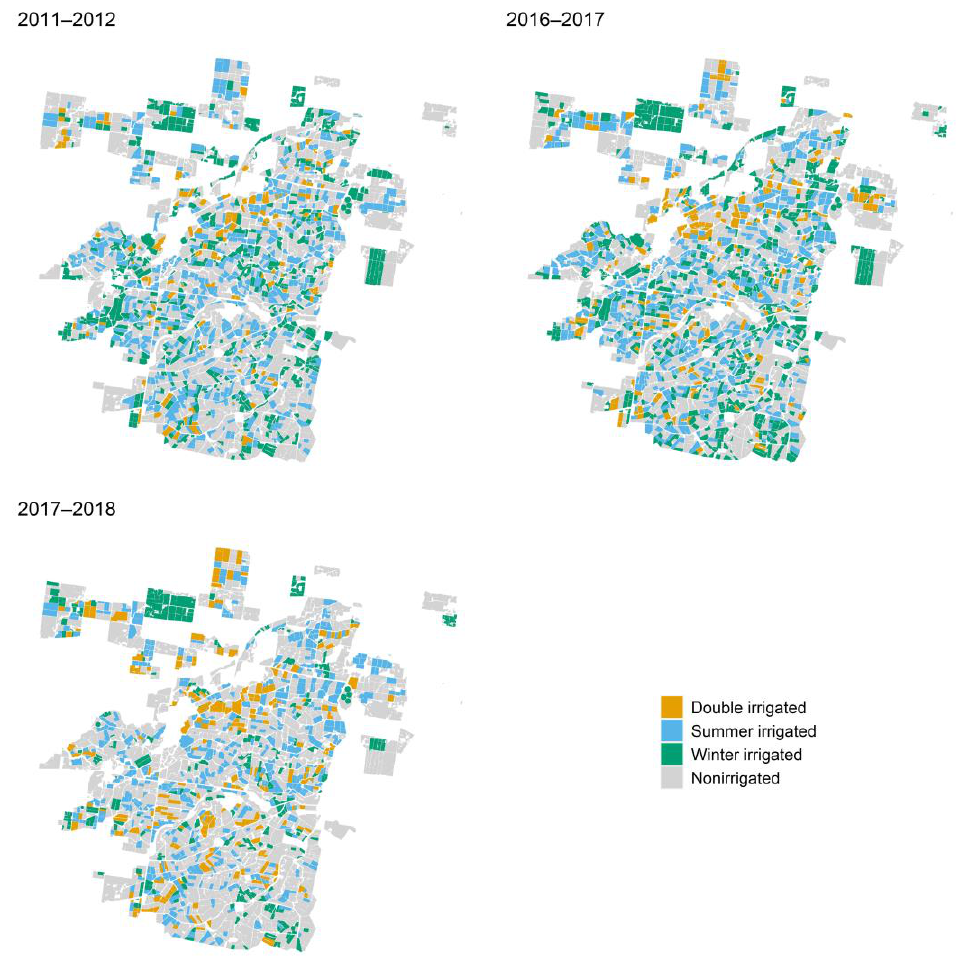
Figure 11. The irrigated area maps for 2011 – 2012, 2016 – 2017 and 2017 – 20 18. The class “Double irri-